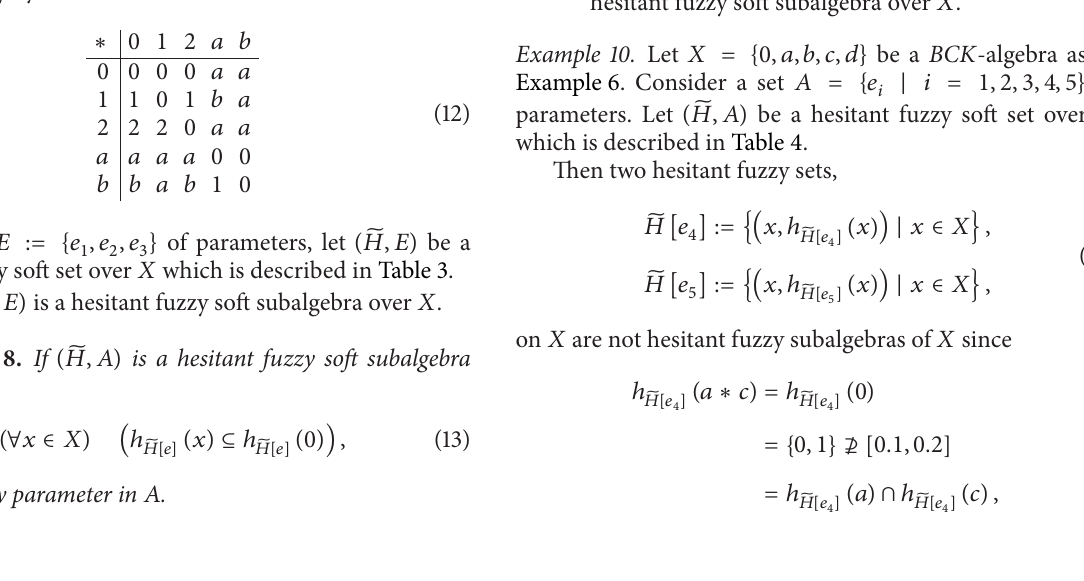
Table 2: Tabular representation of the hesitant fuzzy soft set